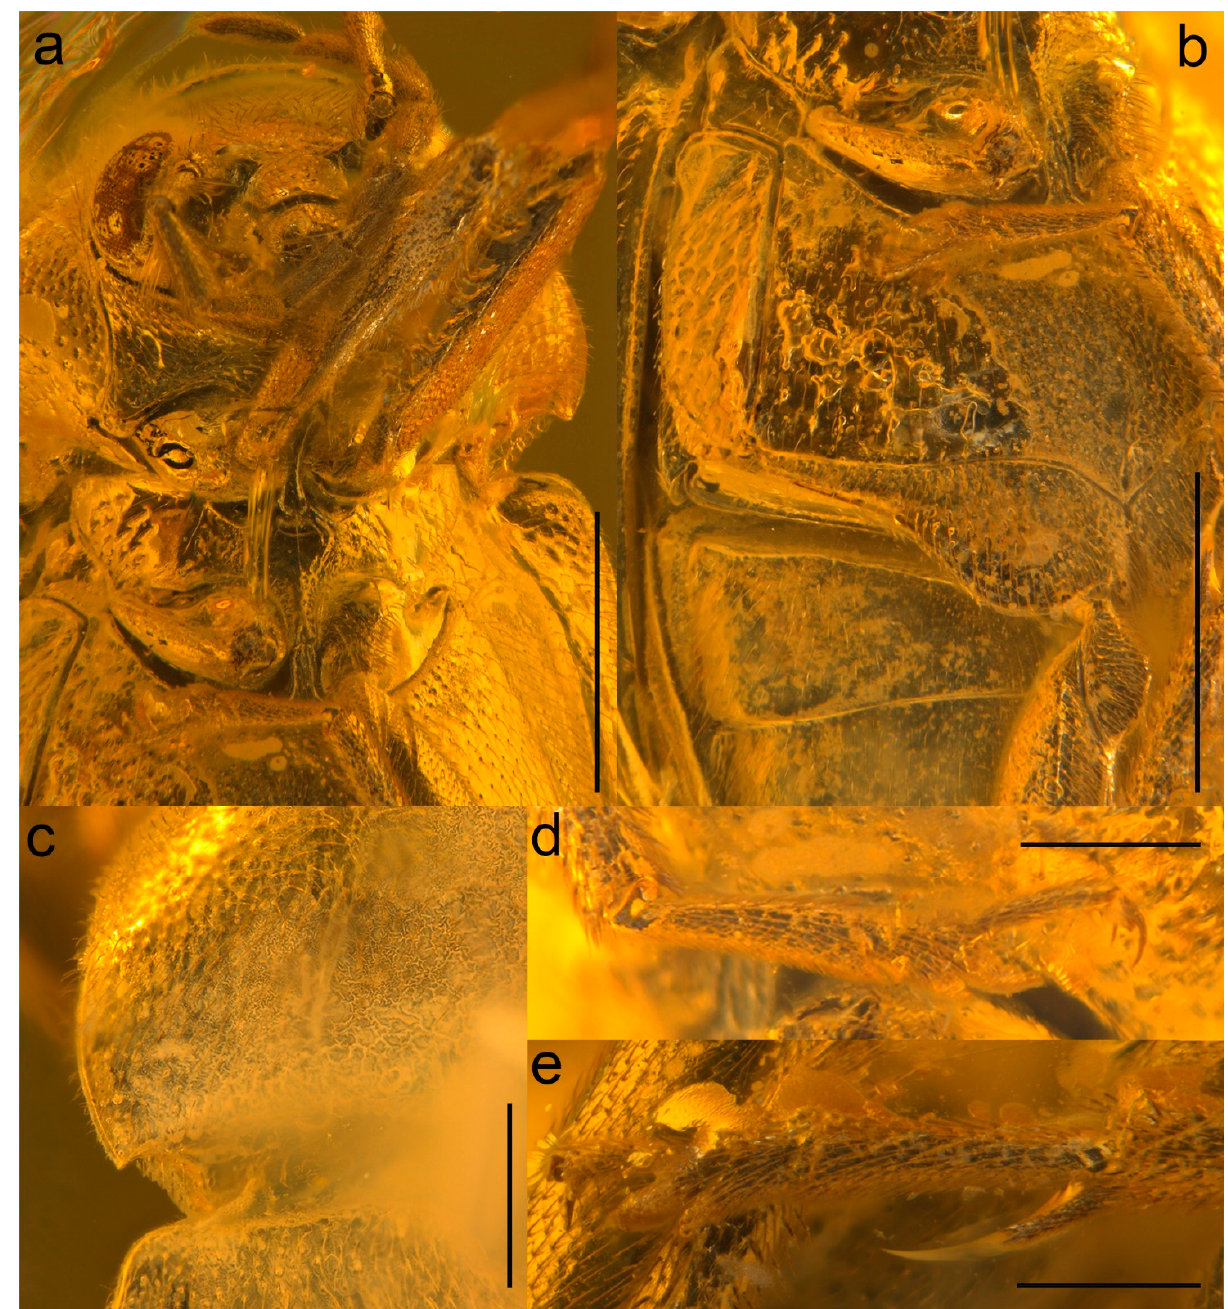
Figure 2. Ptilodactyla eocenica Kundrata, Bukejs and Blank, sp. nov., details of morphology. ( a ) Head and thorax; ( b ) metacoxal plate; ( c ) pronotum, dorsal view; ( d ) mesotarsus; ( e ) metatarsus. Scale bars = ( a , b ) 1.0 mm; ( c ) 0.5 mm; ( d , e ) 0.3 mm.